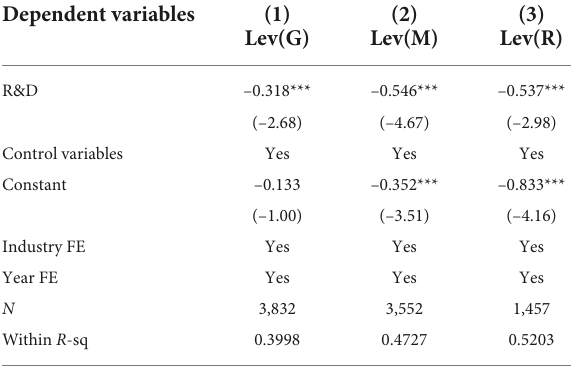
TABLE 11 Impact analysis of business life cycle.